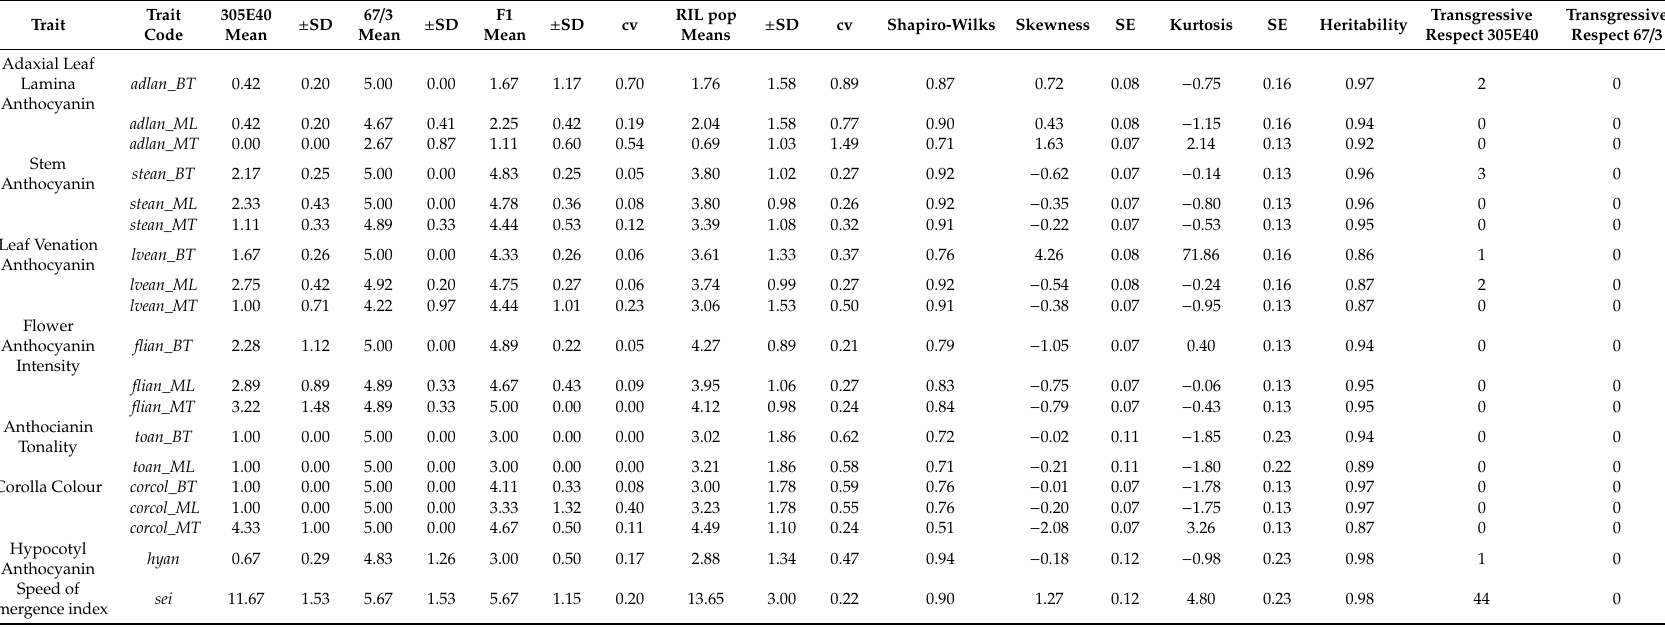
Table 1. List of the traits analyzed and their code, means, standard deviations (SD), coe ffi cients of variation (cv), broad sense heritability and transgressive genotypes for the traits in